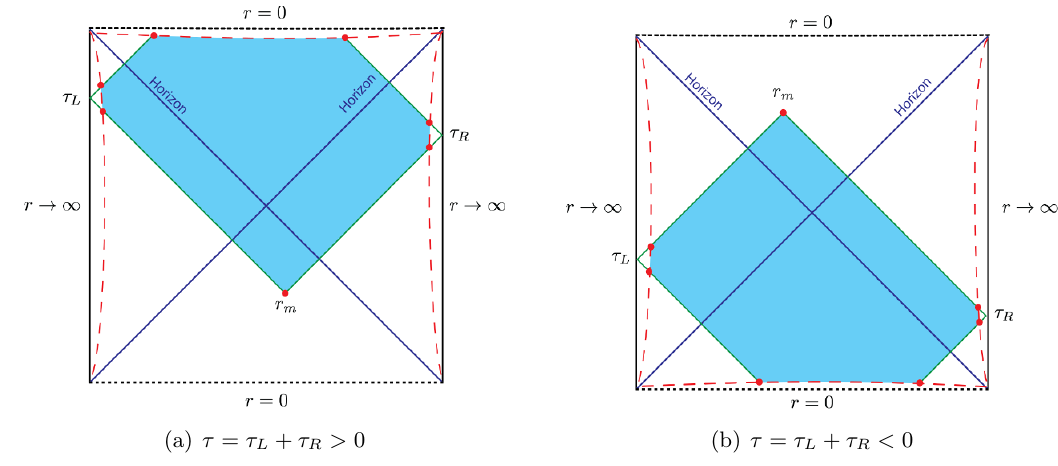
Figure 16 . The WDW patches in the BTZ black hole background. The dashed lines represent the cuto(cid:11) surfaces. The left (right) panel illustrates the case in which (cid:28) = (cid:28) L + (cid:28) R > 0 ( (cid:28) = (cid:28) L + (cid:28) R <